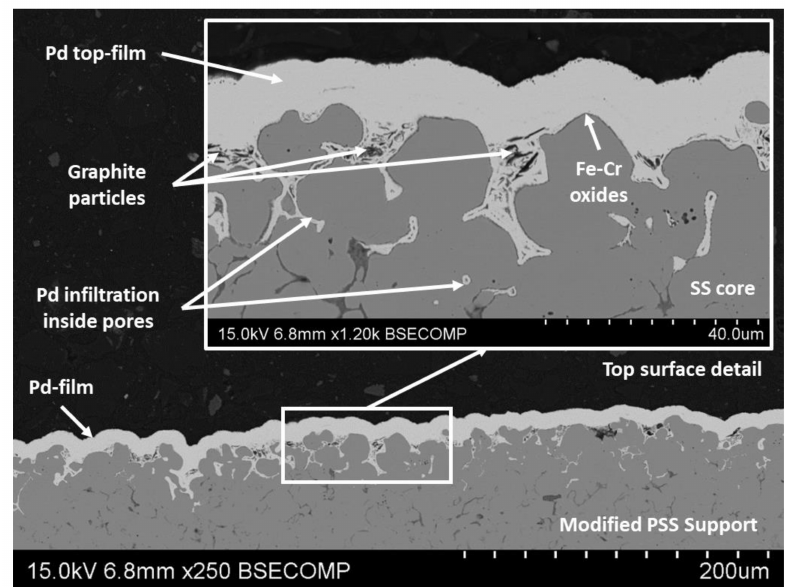
Figure 4. Cross-section of the Pd composite membrane at various